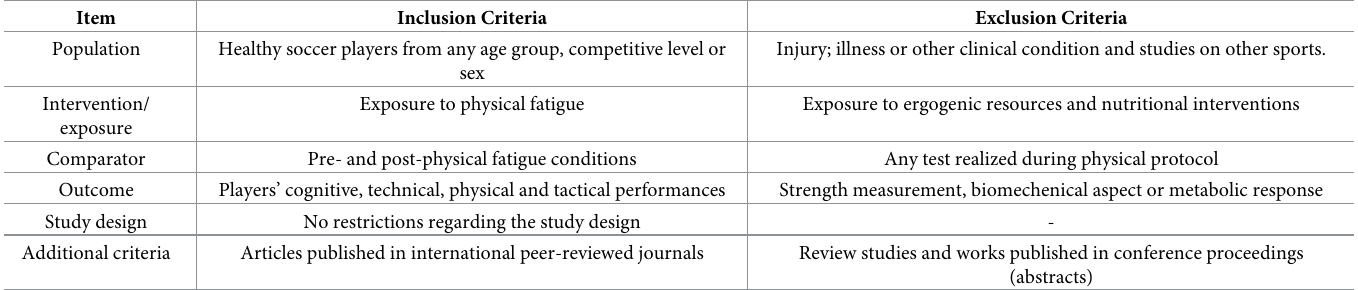
Table 2. Inclusion and exclusion